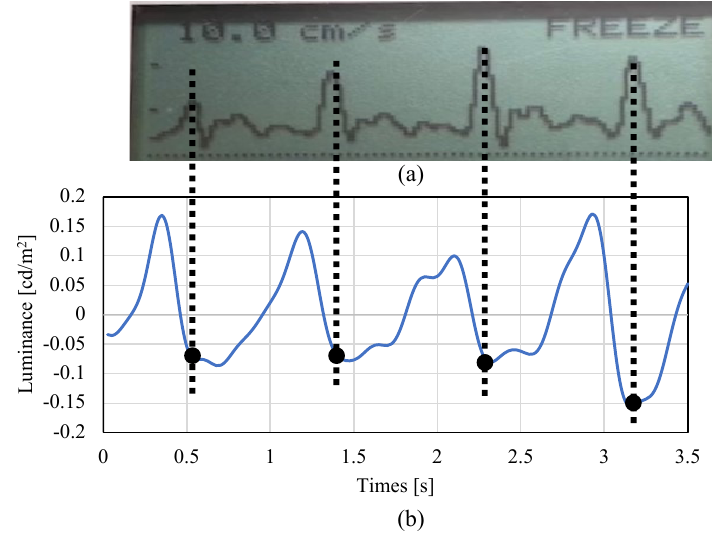
Figure 10. Comparison with reference data. ( a ) Reference data obtained by bidirectional Doppler flowmeter. ( b ) Measurement data by the developed system with blue light source at radial artery. Since the observed pulse wave was inverted in the developed system, both periods were compared in the minimum values. It was confirmed that the period of the peak value of the blood flow meter (reference) and the peak value of the radial artery were in agreement.